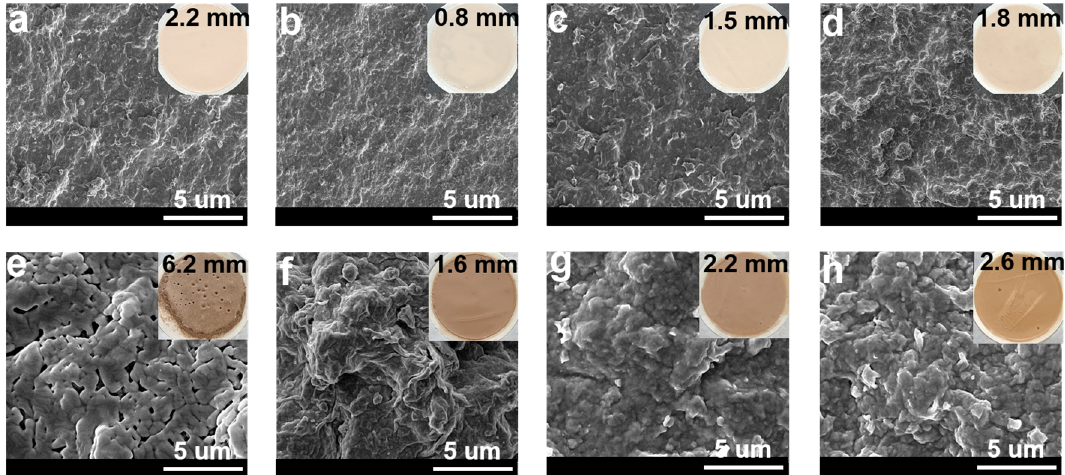
Figure 6. SEM and digital images of mud cakes deposited from different drilling fluids: ( a , e ) 4% bentonite, ( b , f ) 4% bentonite + 2.0 wt% NS-ANAD, ( c , g ) 4% bentonite + 2 wt% NS-ANAD + 5 wt% NaCl, ( d , h ) 4% bentonite + 2 wt% NS-ANAD + 36 wt% NaCl. ( a – d ) Mud cake formed at 25 °C. ( e – h ) Mud cake formed after aged at 200 °C for 16 h.